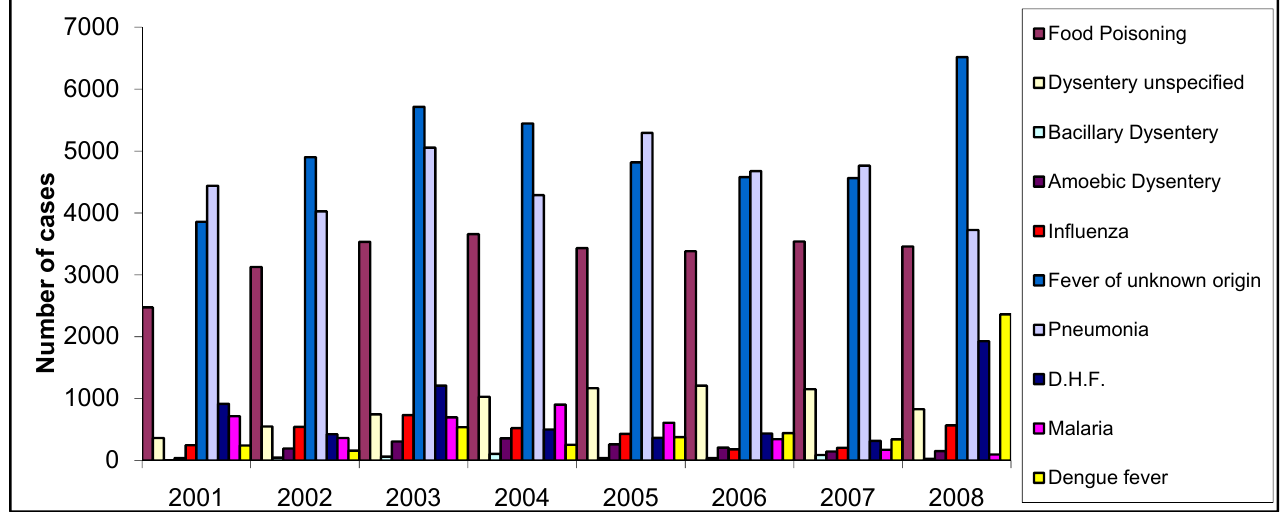
Figure 1. The top 10 diseases with the highest incidence during